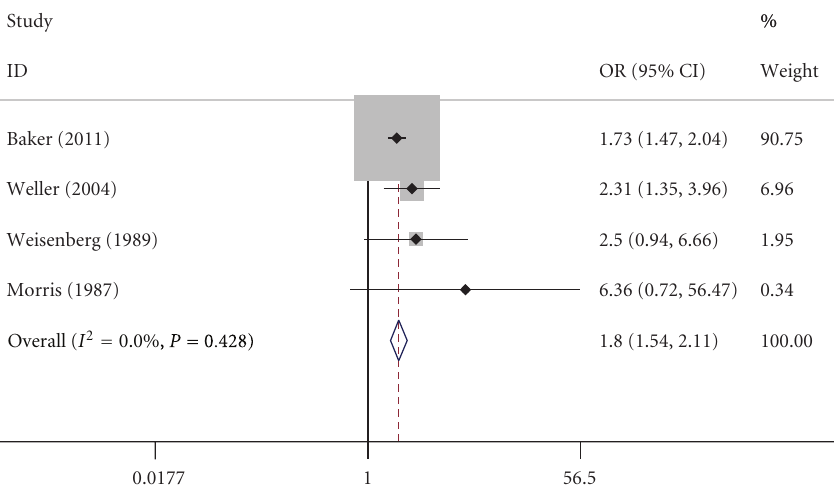
Figure 3: Pooled estimate of OR and 95% CI of AD and hip fracture (used dichotomous data). OR is represented by squares, whose sizes are proportional to the sample size of the relative study. The whiskers represent the 95% CI. The diamond represents the pooled estimate based on the random e ff ects model, with the centre representing the point estimate and the width the associated 95% CI.